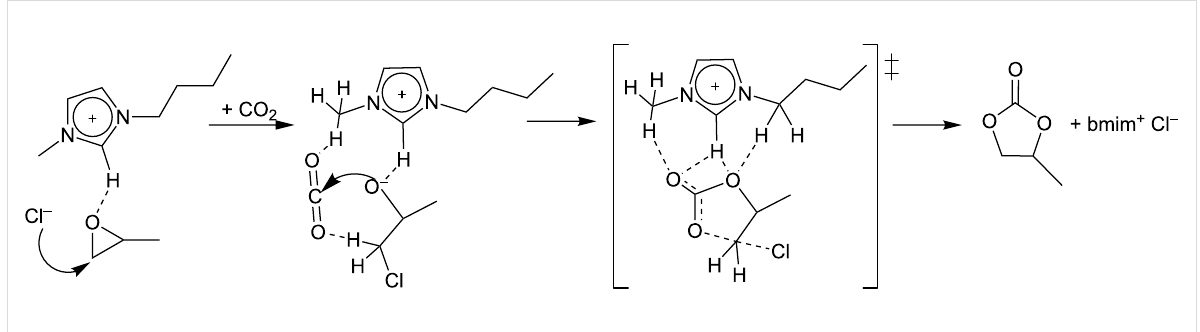
Scheme 5: Two-step pathway for the cycloaddition of propylene oxide and CO 2 in the ionic liquid 1-butyl-3-methylimidazolium chloride (bmim + Cl − ).